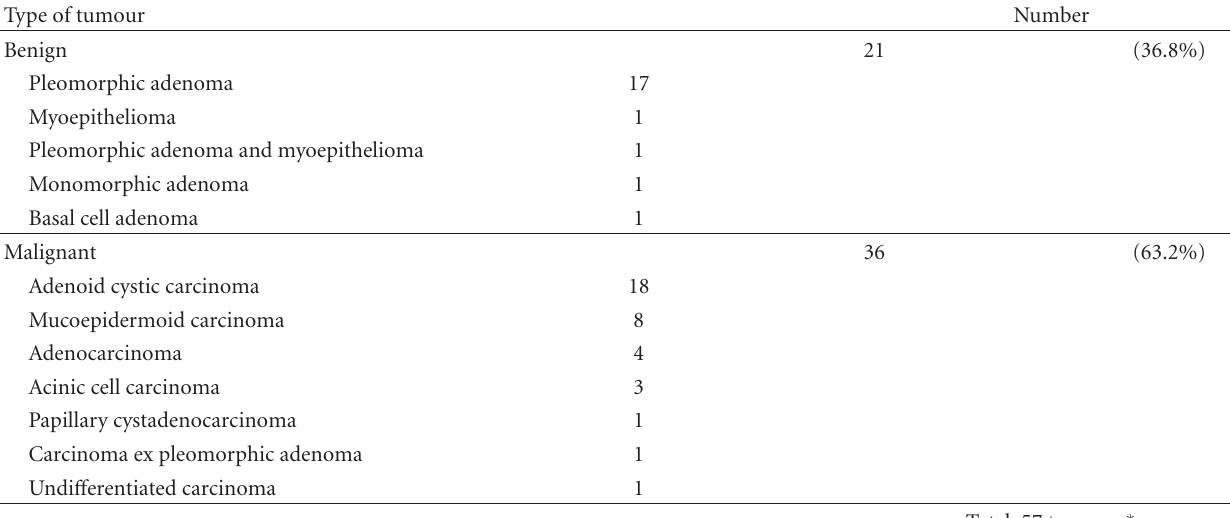
Table 2: Histological type of minor salivary gland